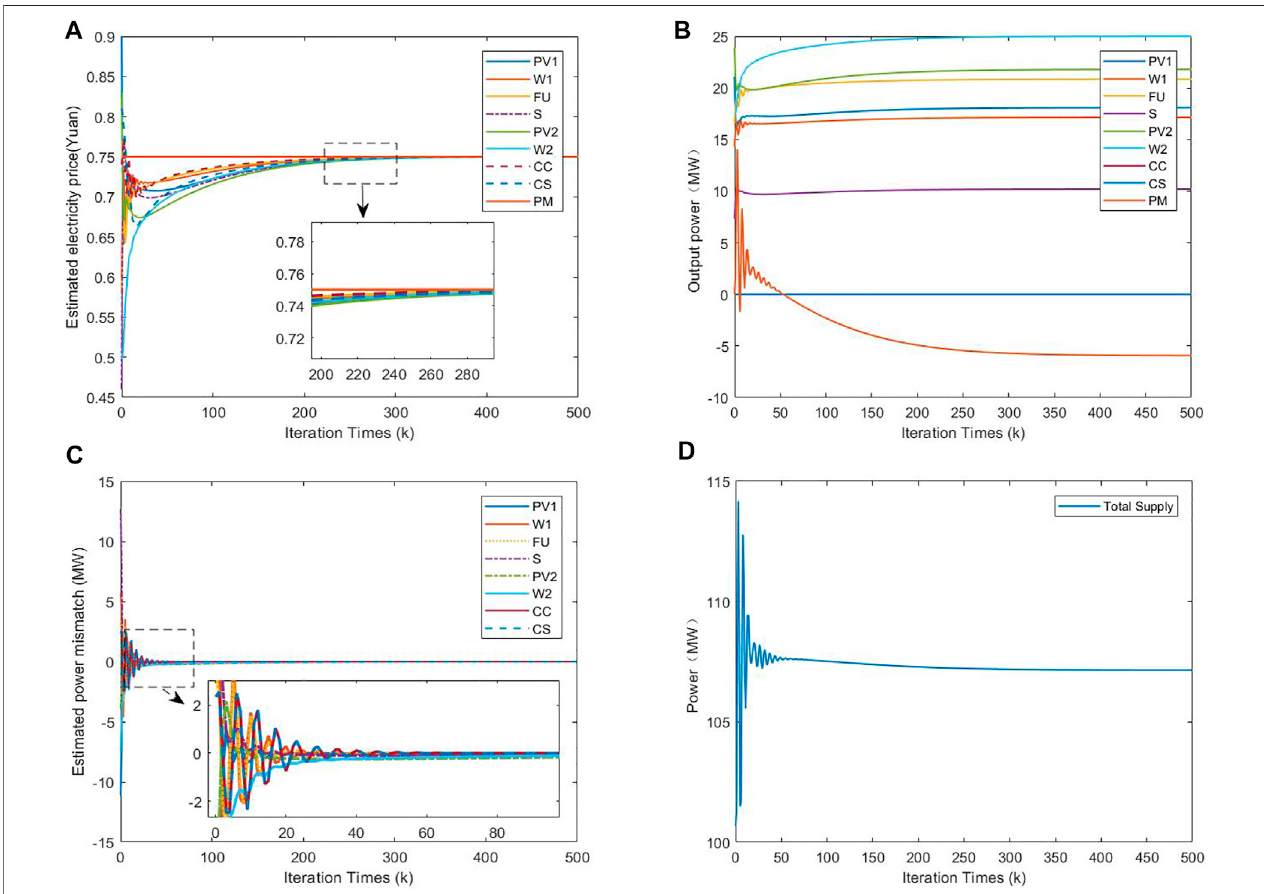
FIGURE6| Simulationresultsofpowersellingtothemaingridingrid-connectedmode. (A) isthedynamiccurveoftheelectricityprice λ , (B) isthedynamiccurveof the power output, (C) is the dynamic curve of the estimated power, (D) is the dynamic curve of the total supply.